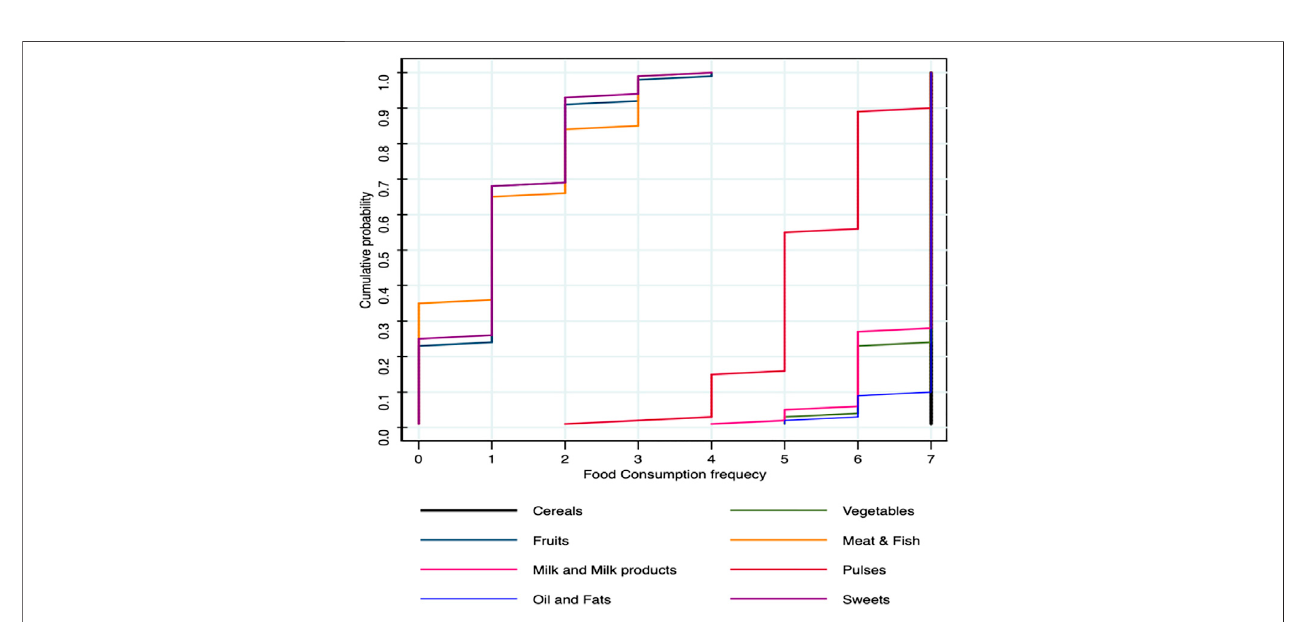
FIGURE 6 | Cumulative probabilty of the